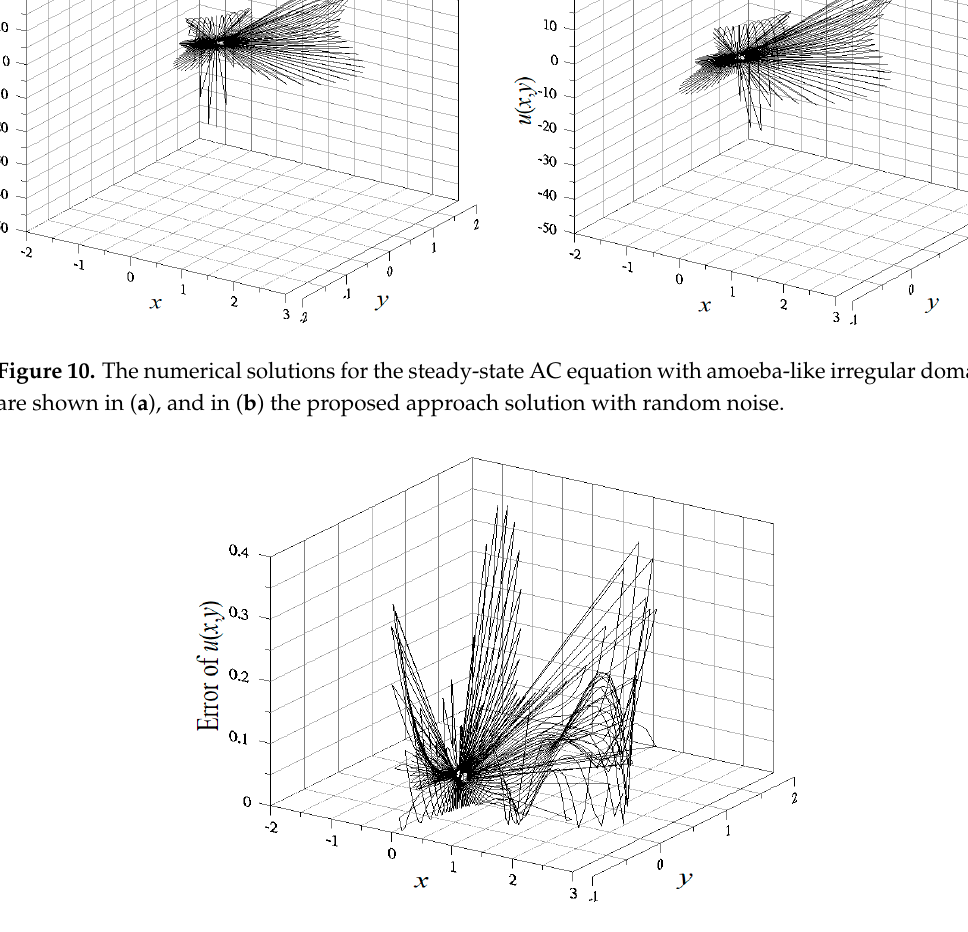
Figure 11. The numerical errors with random noise.